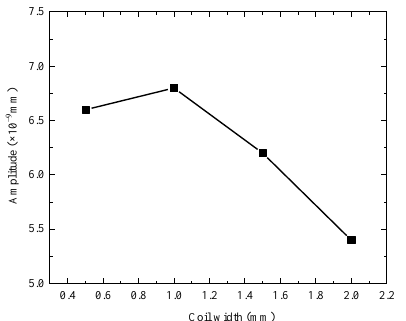
Figure 19. The influence of lift-off distance on the amplitude of received signal.